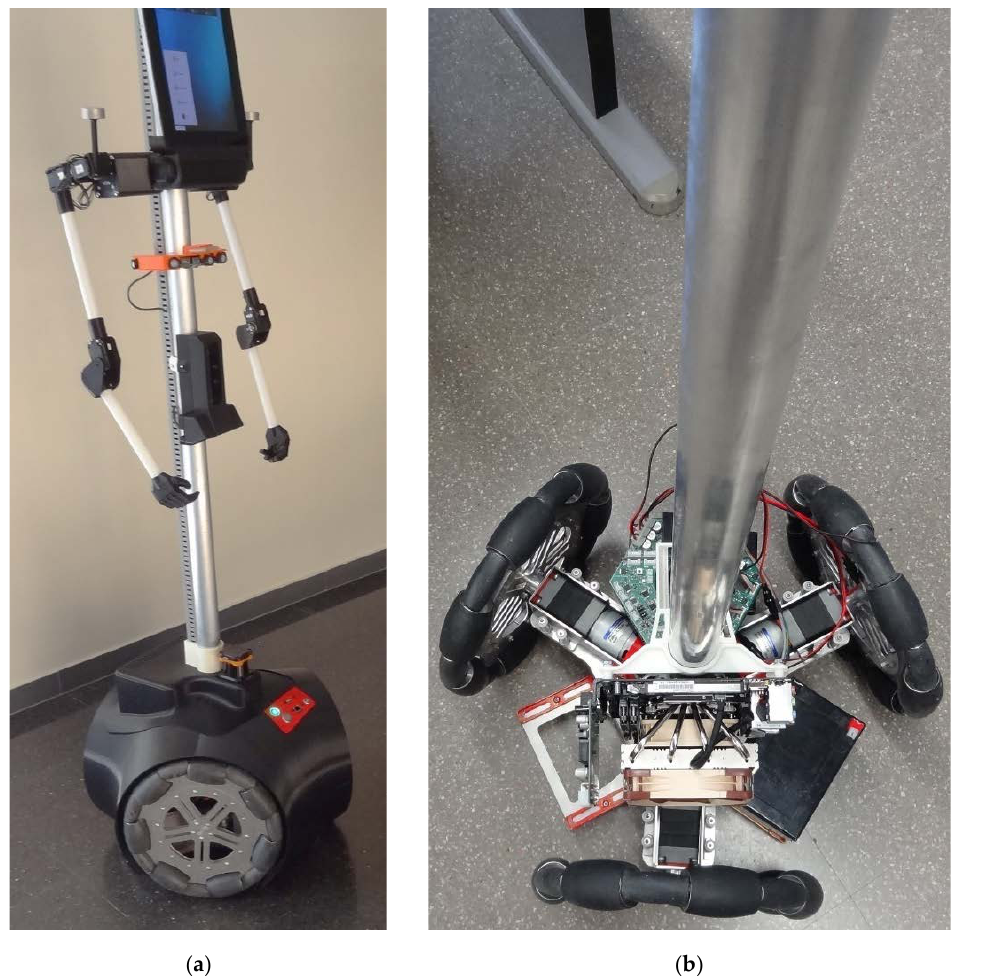
Figure 1. Mobile robot APR-02: ( a ) general view of the mobile robot and ( b ) detail of its omnidirec- tional motion system.